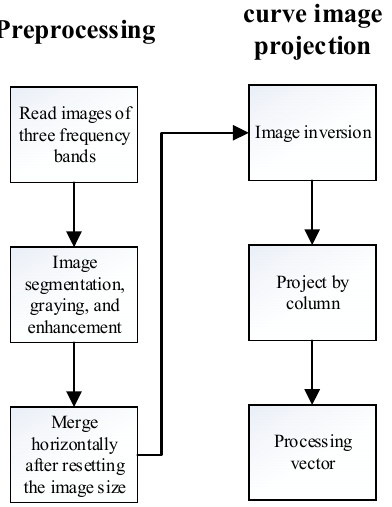
Figure 5. Curve image quantization flowchart.